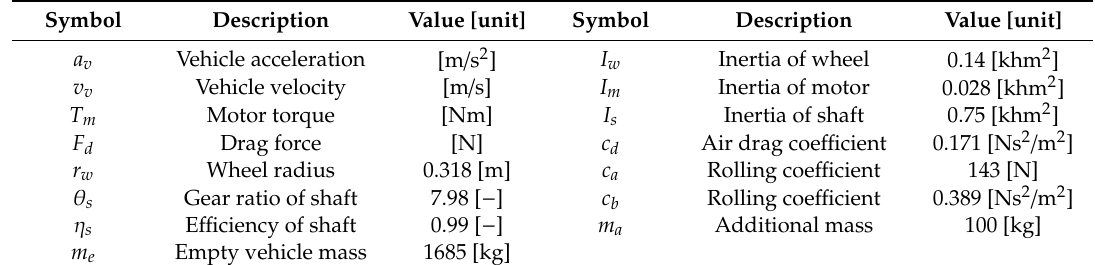
Figure 4. Vehicle modeling results. Table 1. Vehicle model parameters.